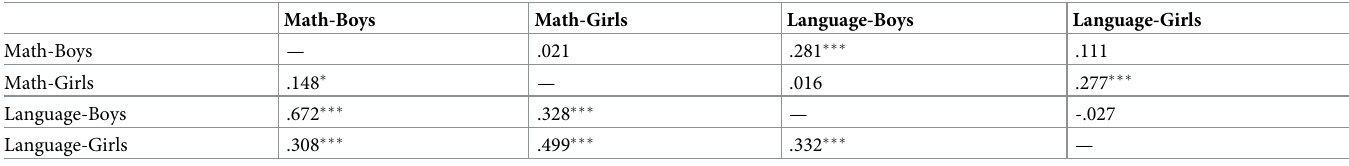
tions of gender differences in academic skills are posited to shape perceptions of the self, class- room motivation and behaviors, and long-term career goals [1,2,60]. In the current study, we examined explicit beliefs and implicit biases regarding perceptions of gender differences in Table 7. Correlations among implicit bias scores (above the diagonal) and explicit gender group competence (below the diagonal).